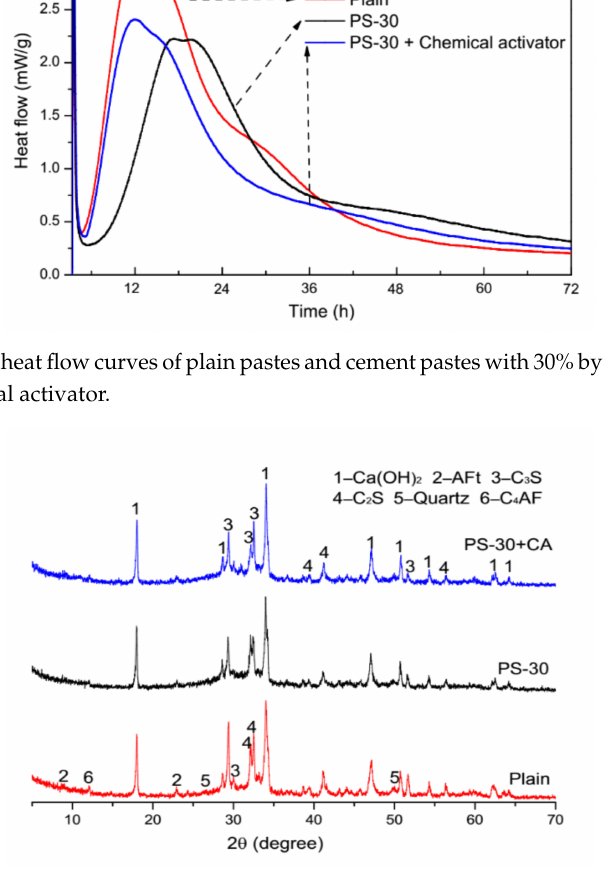
Figure 9. XRD patterns of plain pastes and cement pastes with 30% by mass of phosphorus slag and the chemical activator at 3 days.